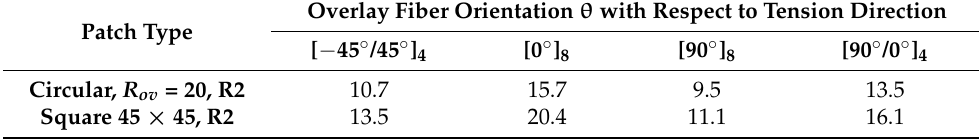
Table 6. Reduction of stress concentration K t in (%). Patch Type Patch